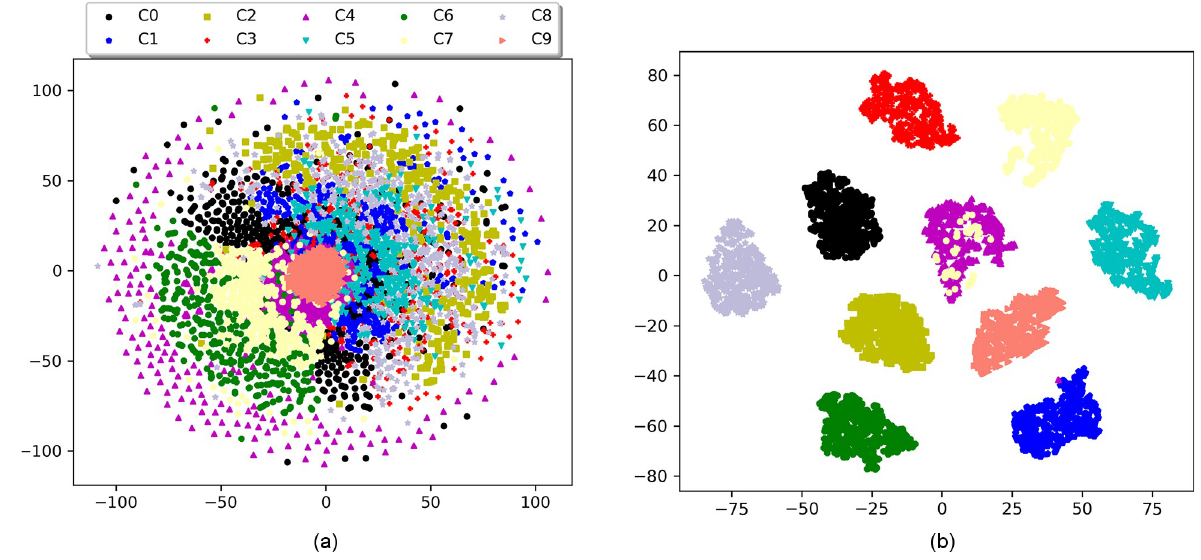
Fig 15. Feature visualization via t-SNE. (a) features of original input data, (b) features extracted by ACGAN-SDAE.